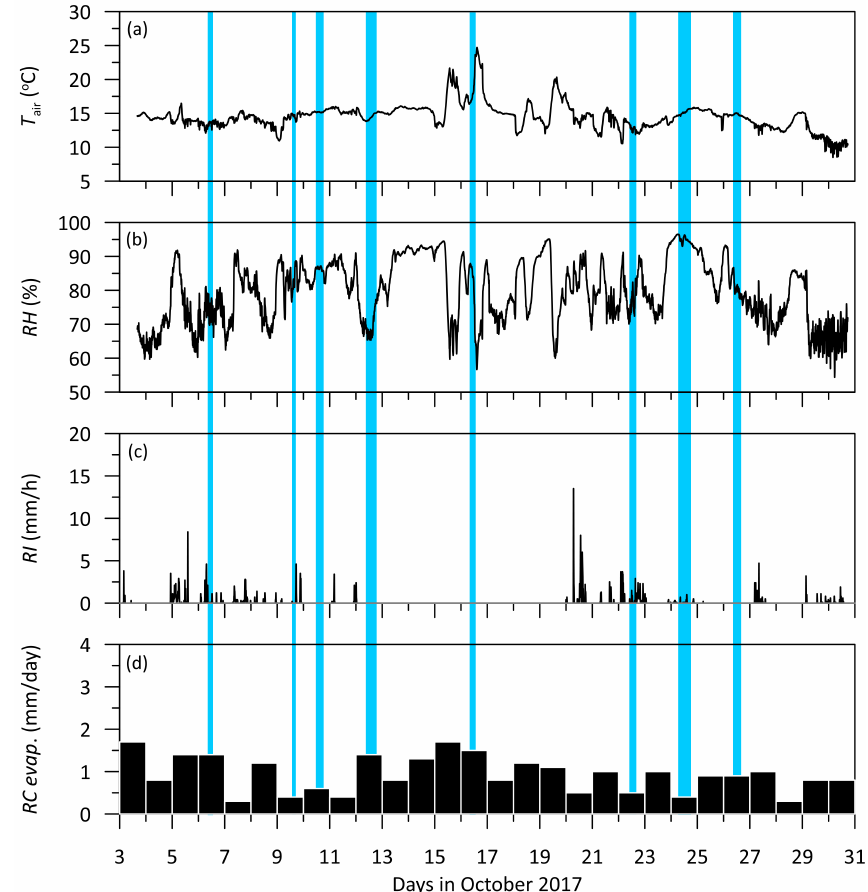
Figure 3. Time series of ( a ) air temperature T air , ( b ) relative humidity RH , ( c ) rain intensity RI and ( d ) reference crop evaporation during Aeolex-II. The data in ( a ) and ( b ) were measured on the beach, those in ( c ) and ( d ) are from the nearby Wijk aan Zee meteorological station operated by the Dutch Royal Netherlands Meteorological Institute. The sky-blue vertical bars represent the moments when surface moisture data were